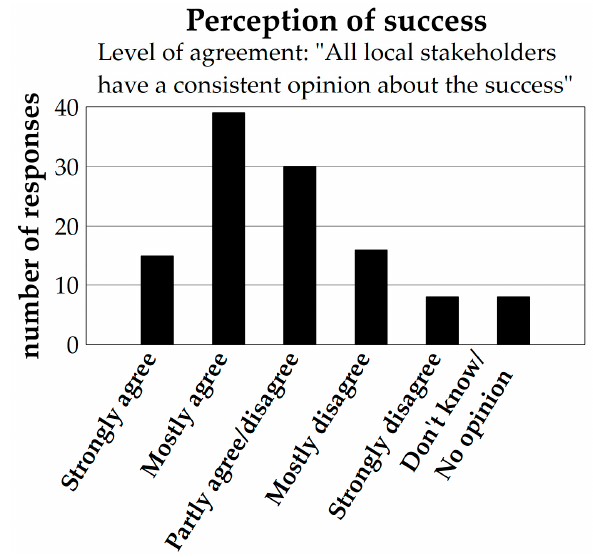
Figure 5. Perceptions of different stakeholders about successes for FLR and combined projects.